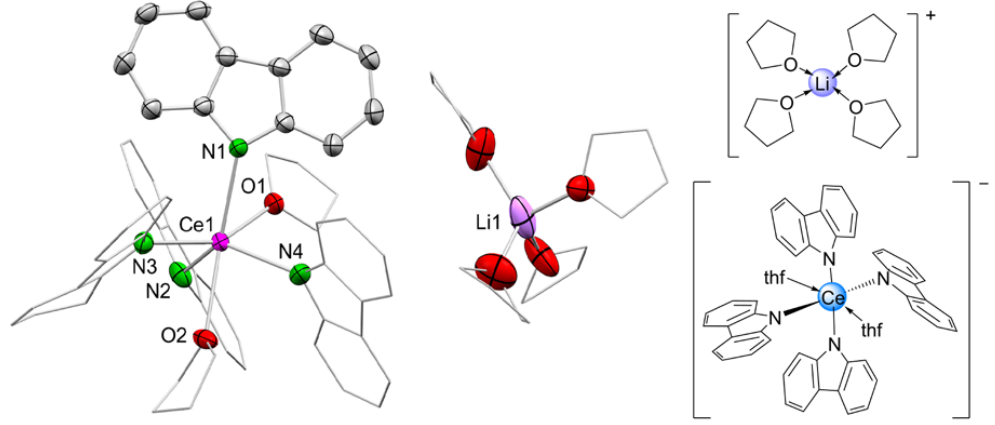
Figure 4. Crystal structure of [Ce(cbz) 4 (thf) 2 ][Li(thf) 4 ] ( 5 ). Ellipsoids are shown at the 50% probability level. Hydrogen atoms and disordered atoms are omitted for clarity. Selected interatomic distances (Å) and angles ( ◦ ): Ce1–N1 2.531(4), Ce1–N2 2.480(4), Ce1–N3 2.497(4), Ce1–N4 2.484(4),